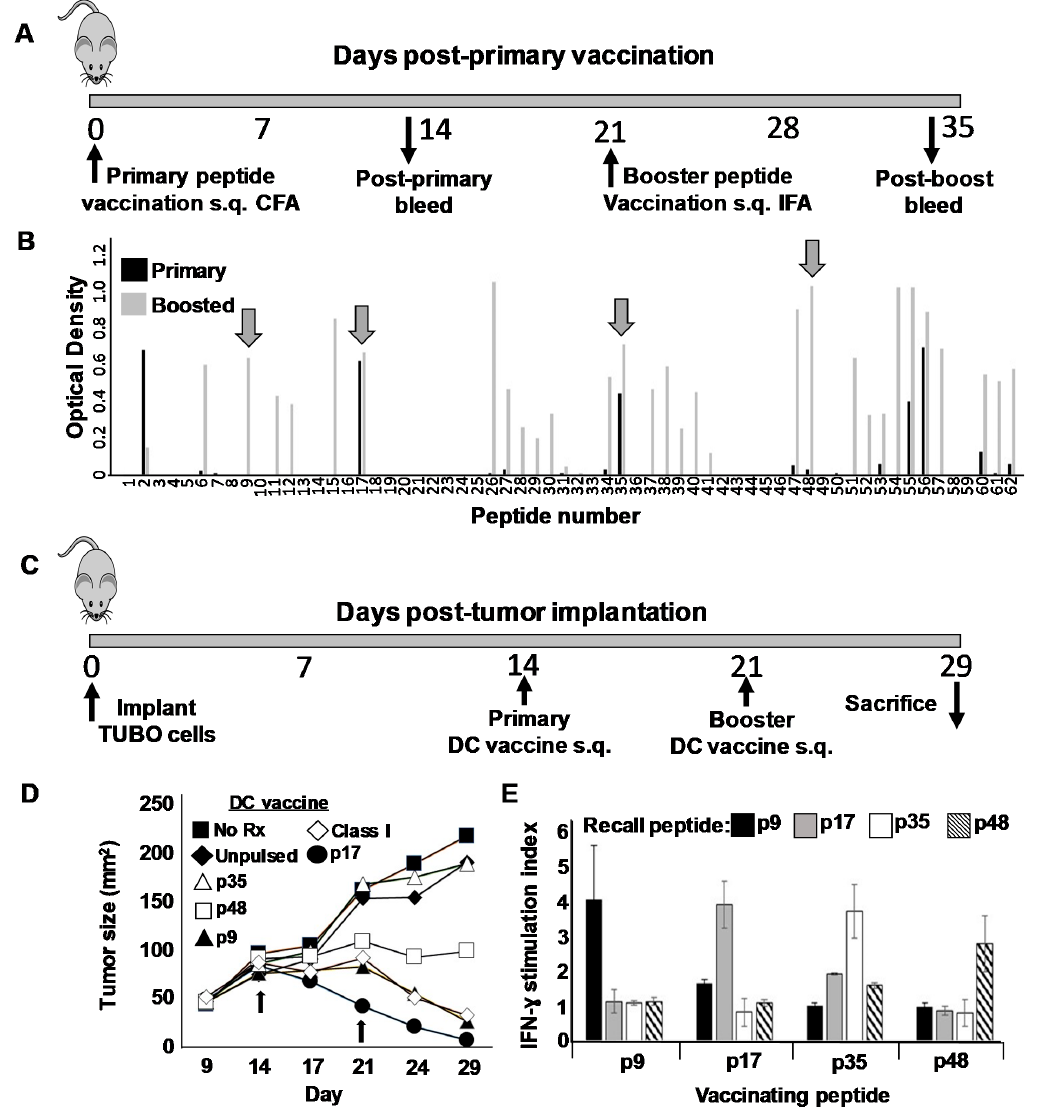
Figure 5. Identification of Helper T cell epitopes on rat ErbB2/HER2. ( A ) Schema of peptide vaccination protocol. On day 0 female Balb/c mice were vaccinated subcutaneously (s.q.) with pools of 5–6 peptides (30 µ g each) based on the rat ErbB2/HER2 extracellular domain sequence and emulsified in Freund’s Complete Adjuvant. On day 21 mice received an identical booster immunization in Freund’s Incomplete adjuvant. Mice were bled 12–14 days after each vaccination (about day 14 and 35) to obtain immune sera. ( B ) ELISA analysis for IgG production against individual pool peptides. Four peptides (indicated by arrows) were selected for further study: p9; QEVQGYMLIAHNQVKRVPLQR, P17; GNPQLCYQDMVLWKDVFRKN, p35; PCARVCYGLGMEHLRGARAI and p48; LIHRNAHLCFVHTVPWDQLF). ( C ) Schema for therapeutic DC vaccination with novel putative Th peptides. Female Balb/c mice (five per treatment group) received 1 × 10 6 TUBO breast carcinoma cells implanted orthotopically on day 0. On days 14 and 21 mice received subcutaneous flank vaccination with 1 × 10 6 SFM DCs pulsed with putative Th peptides p9, p17, p35 and p48. Other groups received DCs pulsed with rat ErbB2/HER2 CTL peptide TYVPANASL (Class I), or unpulsed DC. A final group of tumor-bearing mice was left untreated (No Rx). Mice were monitored for tumor size twice weekly and were sacrificed on day 29. ( D ) Tumor growth curves for mice receiving various indicated SFM-DC vaccines. ( E ) Splenocytes from sacrificed mice vaccinated with SFM-DC pulsed with either p9, p17, p35 or p48 were cultured in the presence of various recall peptides and 24 h supernatants analyzed for IFN- γ via ELISA analysis. Error bars indicate